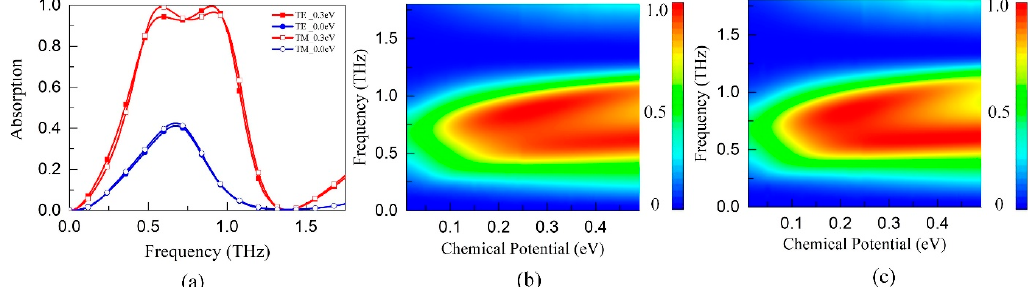
Figure 2. Absorption spectrums of the controllable TMA backed with gold film ( a ) E F = 0.3 eV, TE (transverse electrical) and TM (transverse magnetic); ( b ) as a function of frequency and E F , TE; ( c ) as a function of frequency and E F , TM.